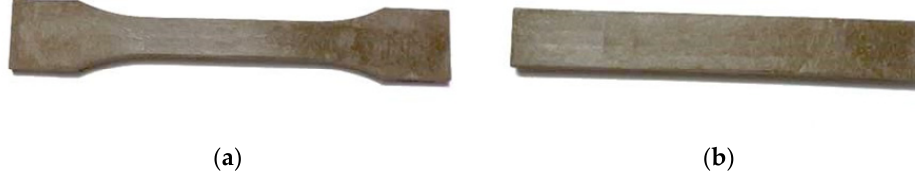
Figure 1. Specimens for: ( a ) tensile test; ( b ) bending test.